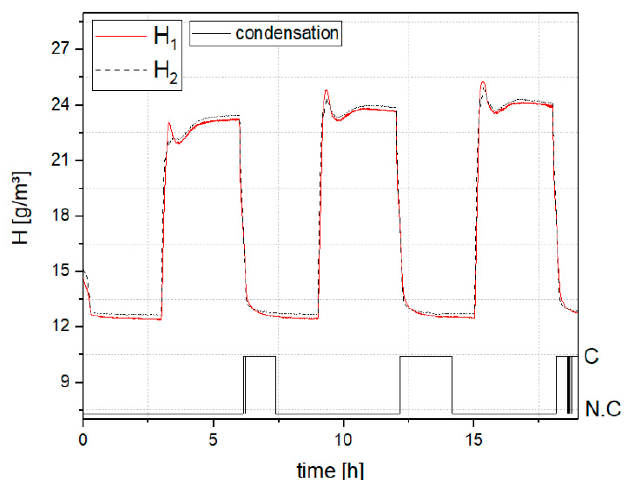
Figure 12. Absolute humidity and condensation measurements for the simulated battery system equipped with PCE during normal operation (for shorter duration test).